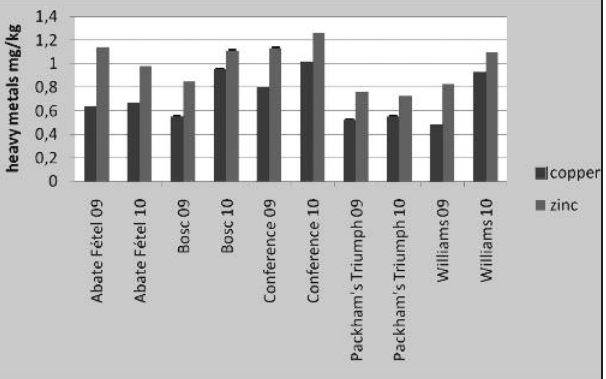
Figure 4: Copper and zinc content in pears 2009–2010